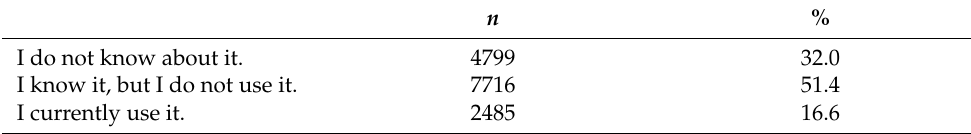
Table 6. The prevalence of “Foods with Nutrient Function Claims”.